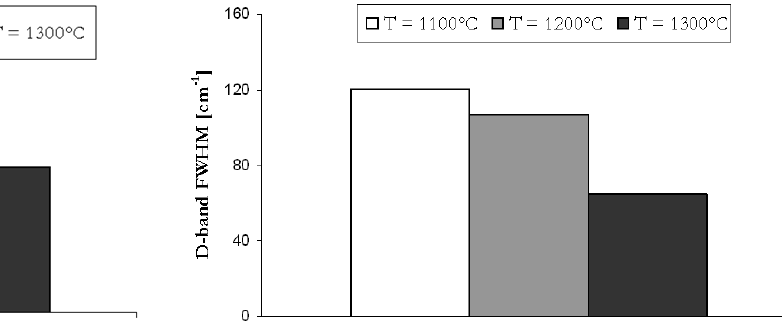
Figure 5: Full width at half maximum (FWHM) of the D band of Py-C deposited at 1100, 1200 and 1300 °C.